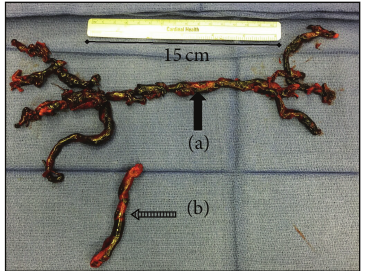
Figure 4: Postoperative demonstration of (a) a large ( ∼ 25 cm) pul- monary embolus en bloc (bold arrow) retrieved from the right and left pulmonary arteries; (b) a long segment of embolus (doted arrow) traversing along tricuspid valve (TV). Both of them were removed in the same open embolectomy under cardiopulmonary bypass